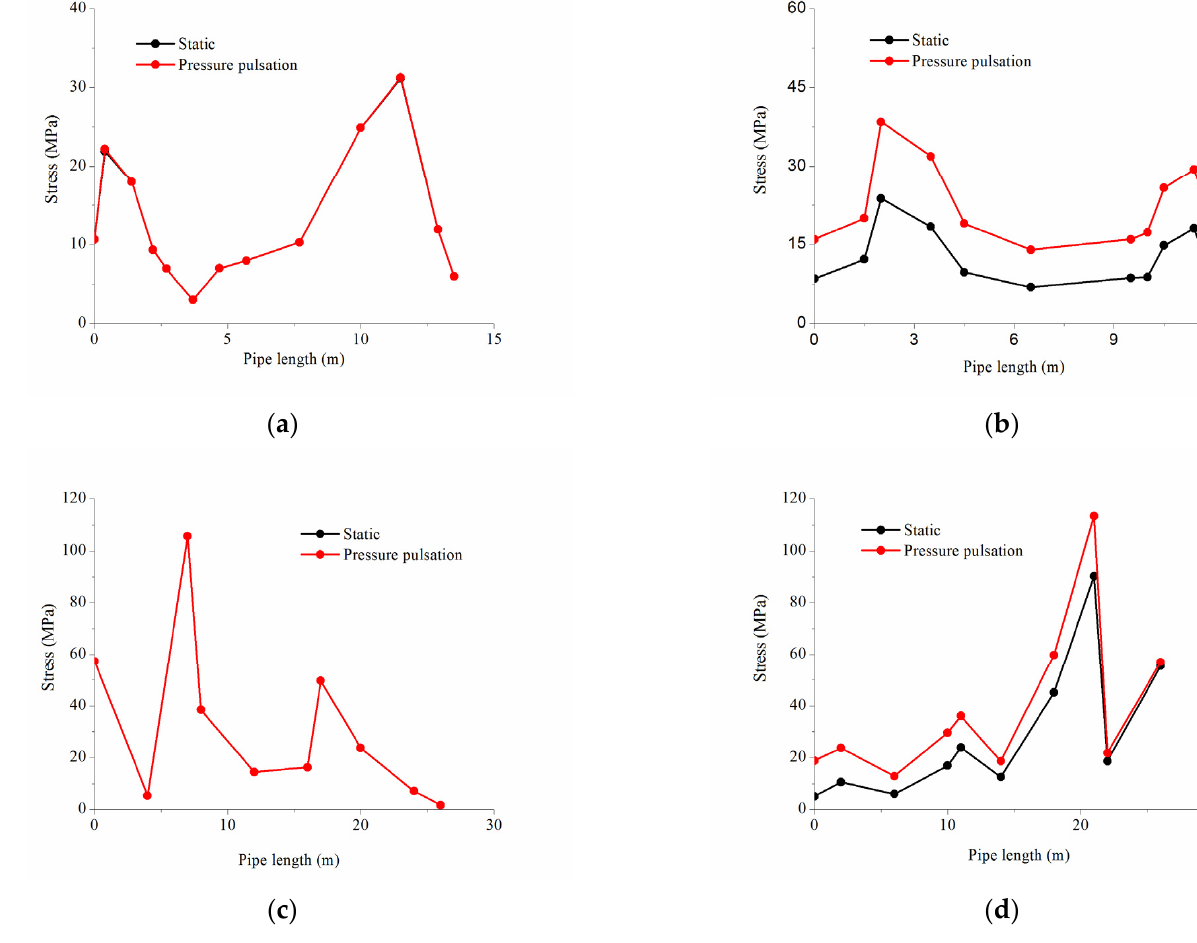
Figure 12. Stress distribution of pipes under static action and pressure pulsation action: ( a ) Compressor (RC1) inlet pipe; ( b ) Compressor (RC1) outlet pipe; ( c ) Main suction pipe; ( d ) Main exhaust pipe.